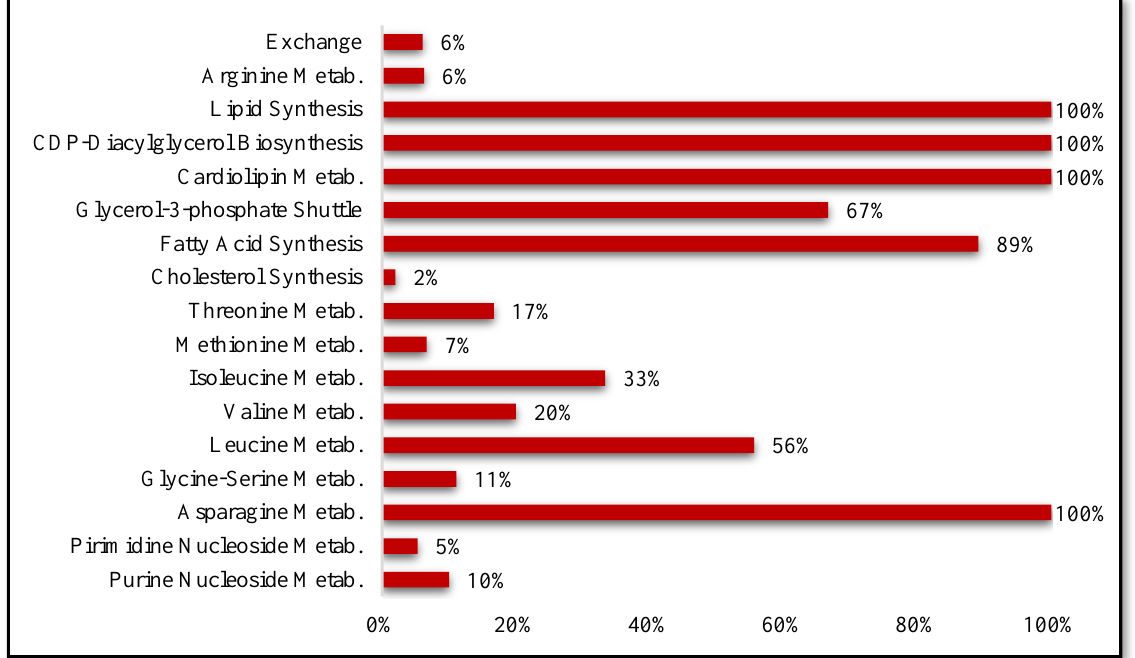
Figure 5. The distribution of reactions directionally related to biomass reaction based on the pathway. The reactions associated with the production of cardiolipin, which is used in the structure of the cell membrane [33], are directly coupled to the biomass reaction (Figure